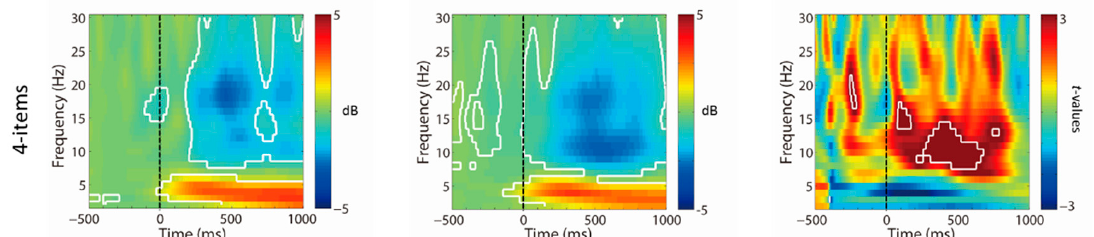
Figure 2. Time–frequency decomposition with Morlet wavelets in the frontal region (Fz). Stimulus-locked rescaled oscillatory power averaged across midfrontal region stimulus in ApoE-4 and non-ApoE-4 groups. The results revealed that the non-ApoE-4 group showed significantly greater decreases in electroencephalogram (EEG) power at the alpha band (9–13 Hz) in the 4-item condition relative to the ApoE-4 group at approximately 250–550 ms following target onset (all p < 0.01, uncorrected).